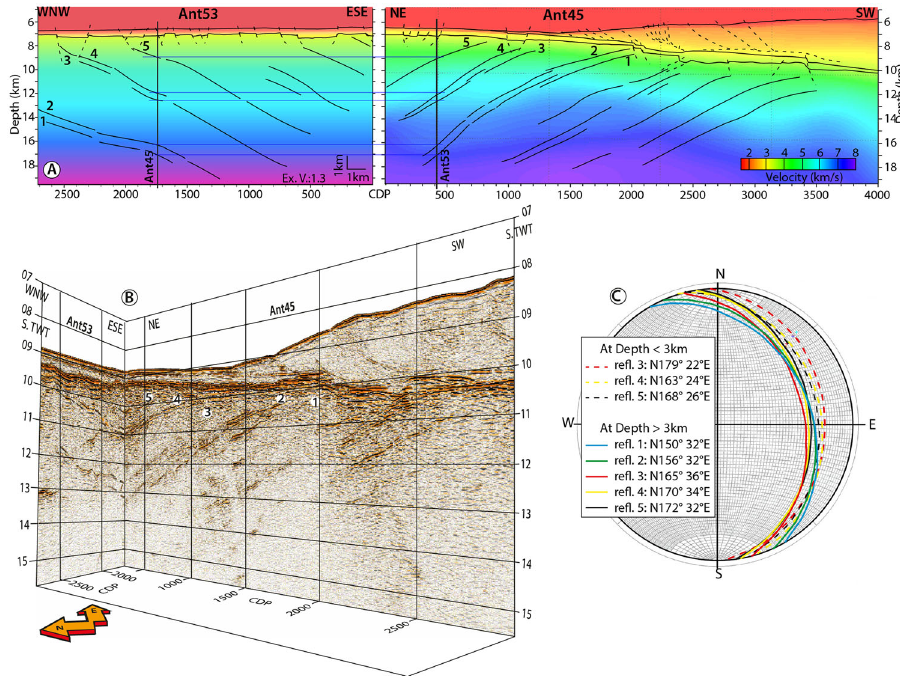
Fig. 3 Geometry and direction of Ridgeward Dipping Re fl ectors. Depth-converted interpretation for lines Ant45 and Ant53 ( A ), 3D view in time section ( B ), and Schmidt diagram ( C ) reveal that the convex-up sequences of RDRs in the oceanic basement dip toward the Mid Atlantic Ridge. Lines location is in Figs. 1B and 3D bathymetry-seismic view for lines Ant45 and Ant53 are in Fig. 2B and Supplementary Fig. 2, respectively. Figure 4 shows an interpreted perspective view of the RDRs.